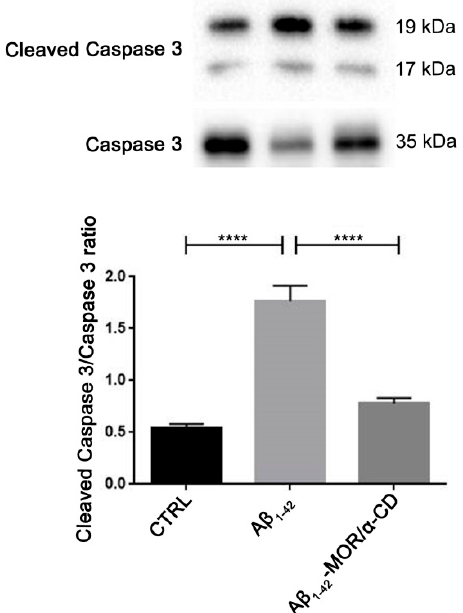
Figure 4. Western Blot analysis for Cleaved caspase 3. A β 1-42 treatment increased protein levels of Cleaved caspase 3, indicating the induction of apoptosis. MOR/ α -CD pretreatment reduced cleaved caspase 3 levels, indicating that it can exert a protective action against A β 1-42 -induced apoptosis. **** p < 0.0001.